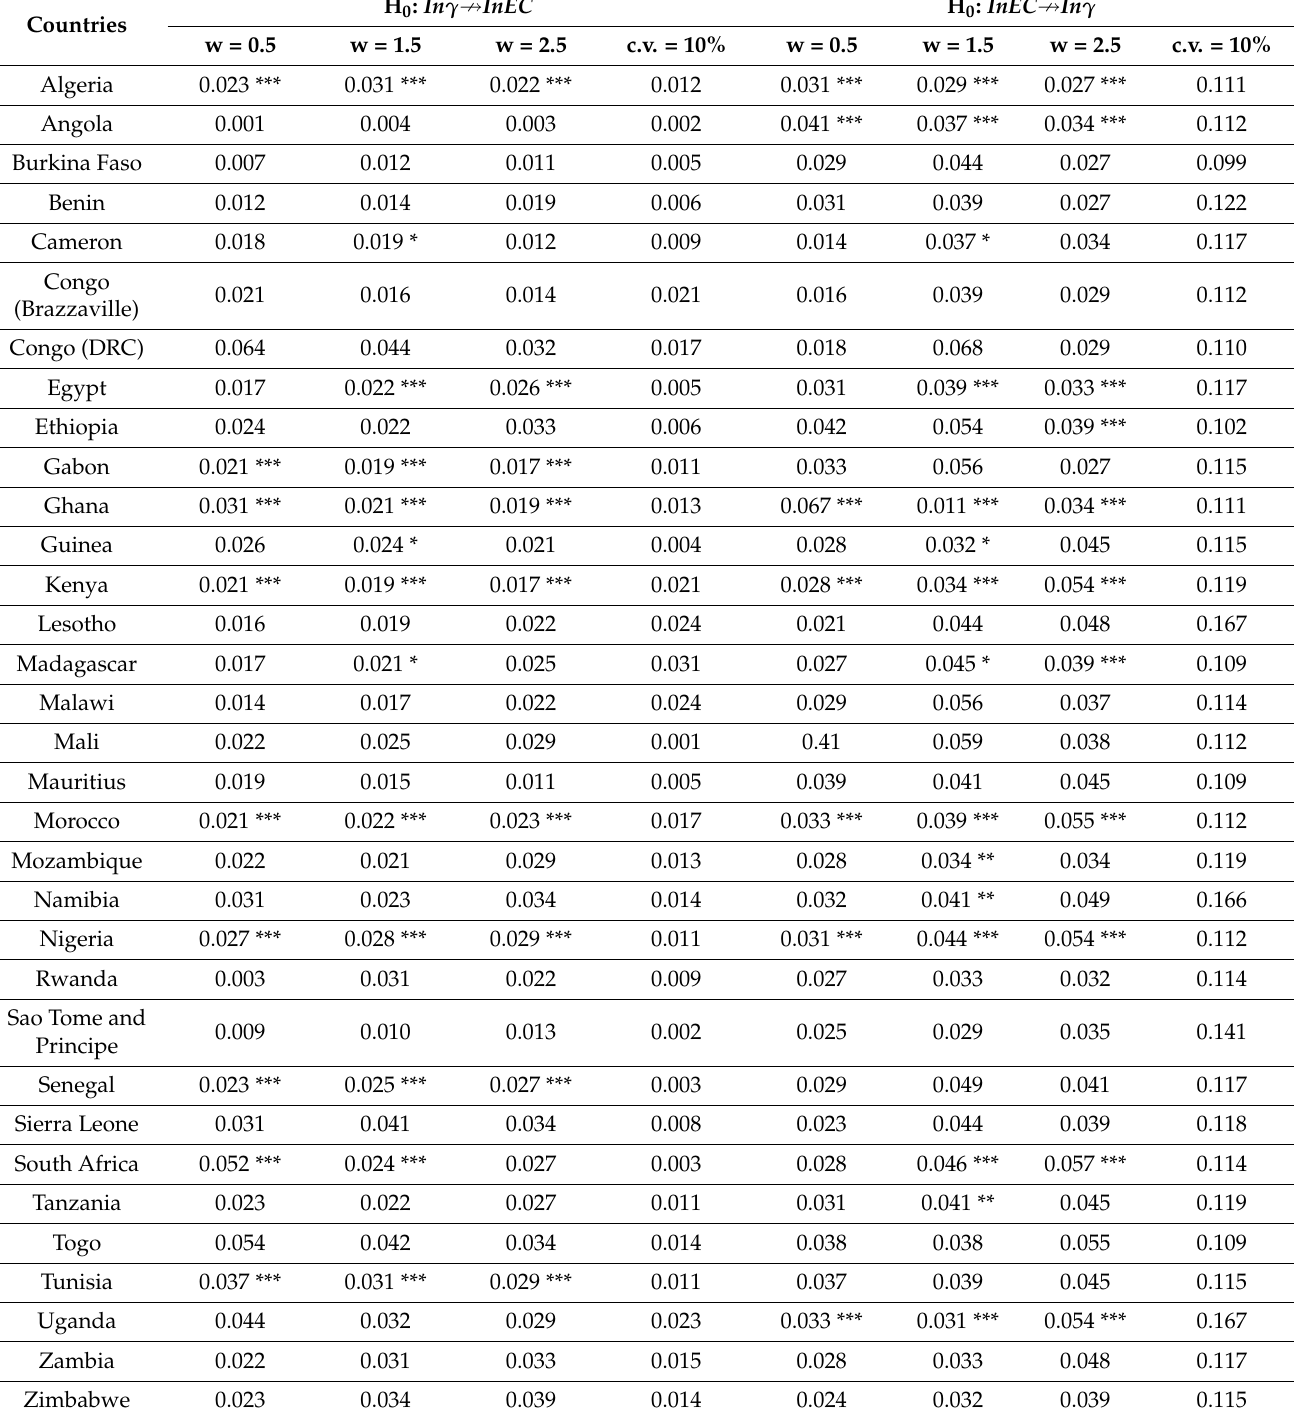
Table 5. Granger causality tests in the frequency domain estimates In γ , InEC